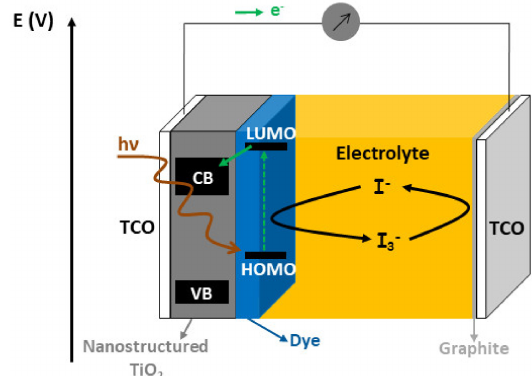
Figure 17. Schematic electron transport pathway in dye-sensitized solar cells